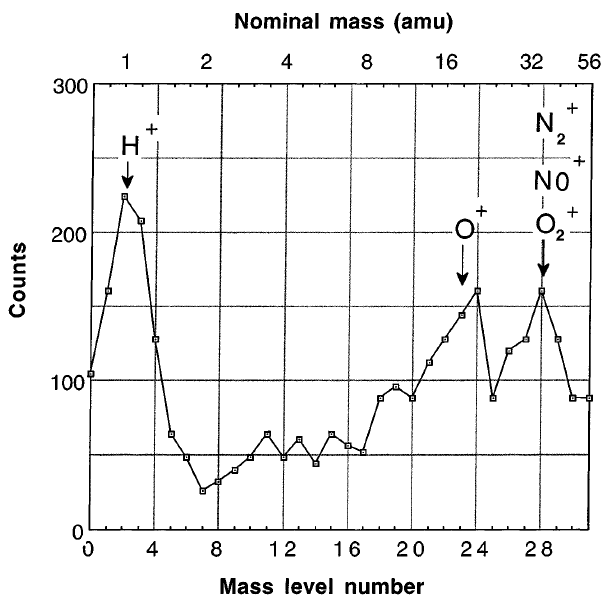
Fig. 10. Mass spectrum obtained at 2153:48–2155:48 UT on January